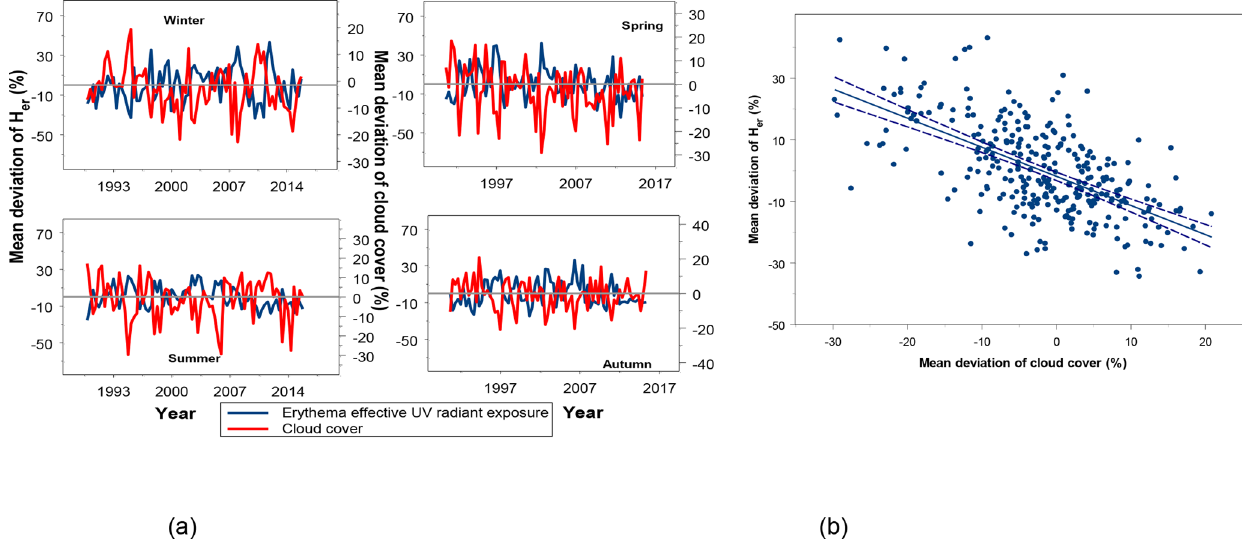
Figure 5. Relationship between the mean deviation of H er (%) and CC at Chilton (1991–2015): (a) seasonal and (b) correlation plot showing the linear regression line with 95% CI. Table 5. Estimated effect of CC on H er (%) with 95% CI, based on three study